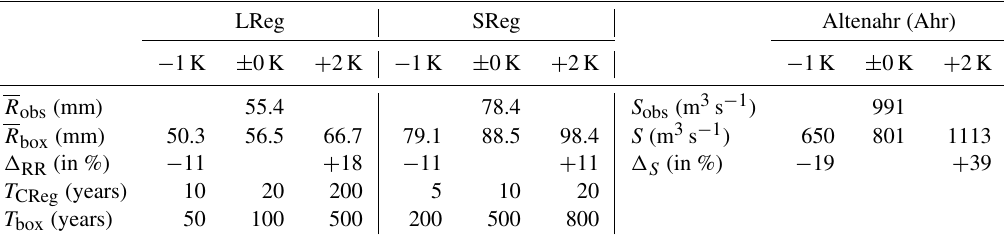
Figure 9. 24h precipitation sums (14 July 2021, 06:00UTC to 15July 2021, 06:00UTC) from PGW experiments using the WRF model. Horizontal distributions for (a) PGW − 1K (PGWcold), (b) control run ± 0K (PGWcontrol), and (c) PGW + 2K (PGWwarm). (d) Area averaged 24h precipitation sums (LReg in blue, SReg in red) plotted against temperature change for all conducted PGW experiments. Solid lines represent linear regression lines that are used for calculating the correction factors for the hydrological discharge modeling (see Sect. 4.1.2). Stippled horizontal lines denote the mean 24h precipitation amount of PGWcontrol (56.5mm for LReg and 88.5mm for SReg). Table 3. Spatially averaged 24h precipitation totals (14 July 2021, 06:00UTC to 15July 2021, 06:00UTC) over the study areas (LReg and SReg) derived from RADOLAN observations R obs and from the PGW simulations R box (with box either LReg or SReg), and relative deviation (cid:49) RR to the control run ( ± 0K); return period T of R box according to LAERTES-EU statistics considering either total CReg ( T CReg ) or only the two smaller study areas ( T box with subscript box standing either for LReg or SReg); and peak discharge S from hydrological PGW simulations with LARSIM at gauge Altenahr (river Ahr) and from observations (reconstructions) S obs , and relative deviation (cid:49) S from the PGW results to the control